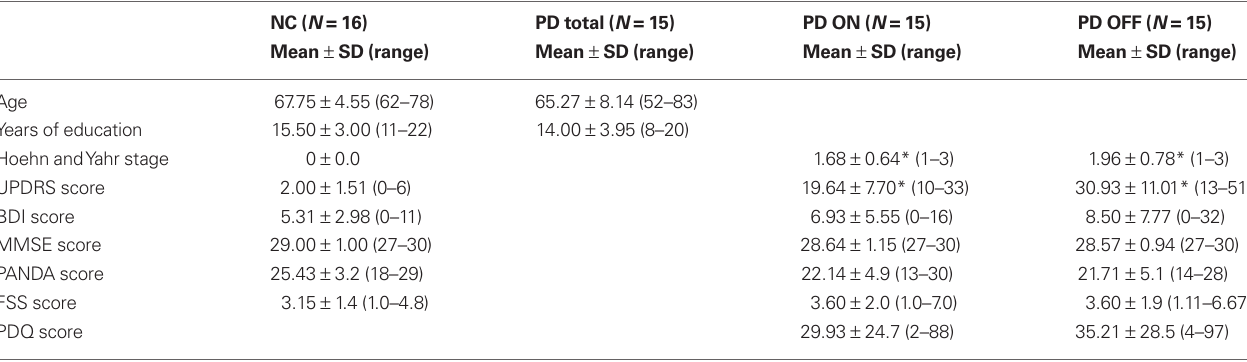
Table 1 | Descriptive statistics for normal control subjects (NC) and PD patients.